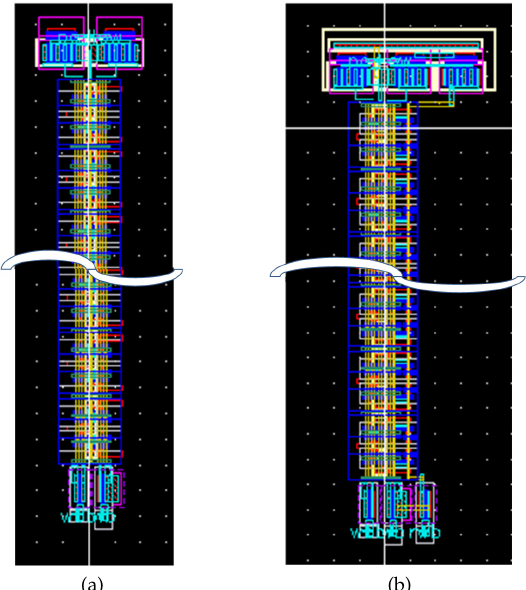
Figure 4. Layout of the 32-bit SRAM, one column. ( a ) 6T and ( b )